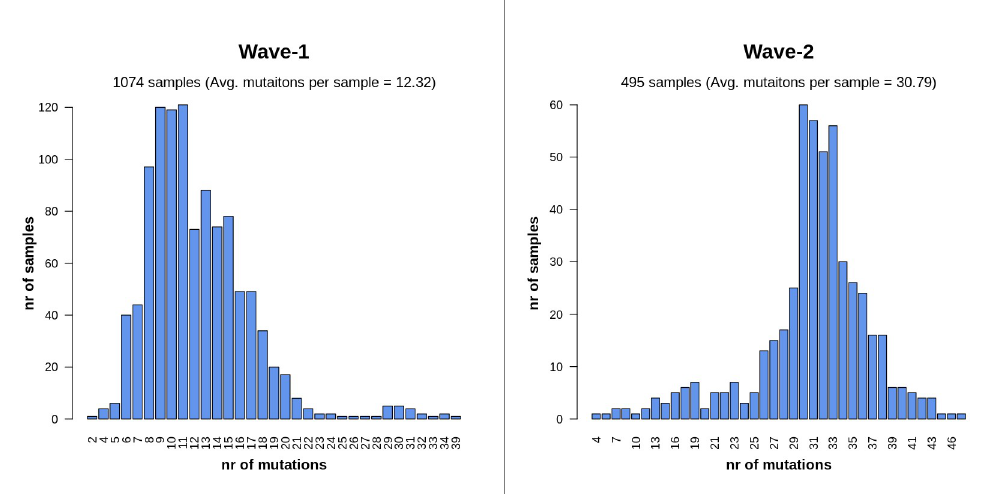
Fig 2. Number of mutations per sample for wave-1 and wave-2. The majority of sequences from wave-1 had 6 to 17 mutations per sample. On the other hand, most of the samples of wave-2 possess on average 28 to 38 mutations.